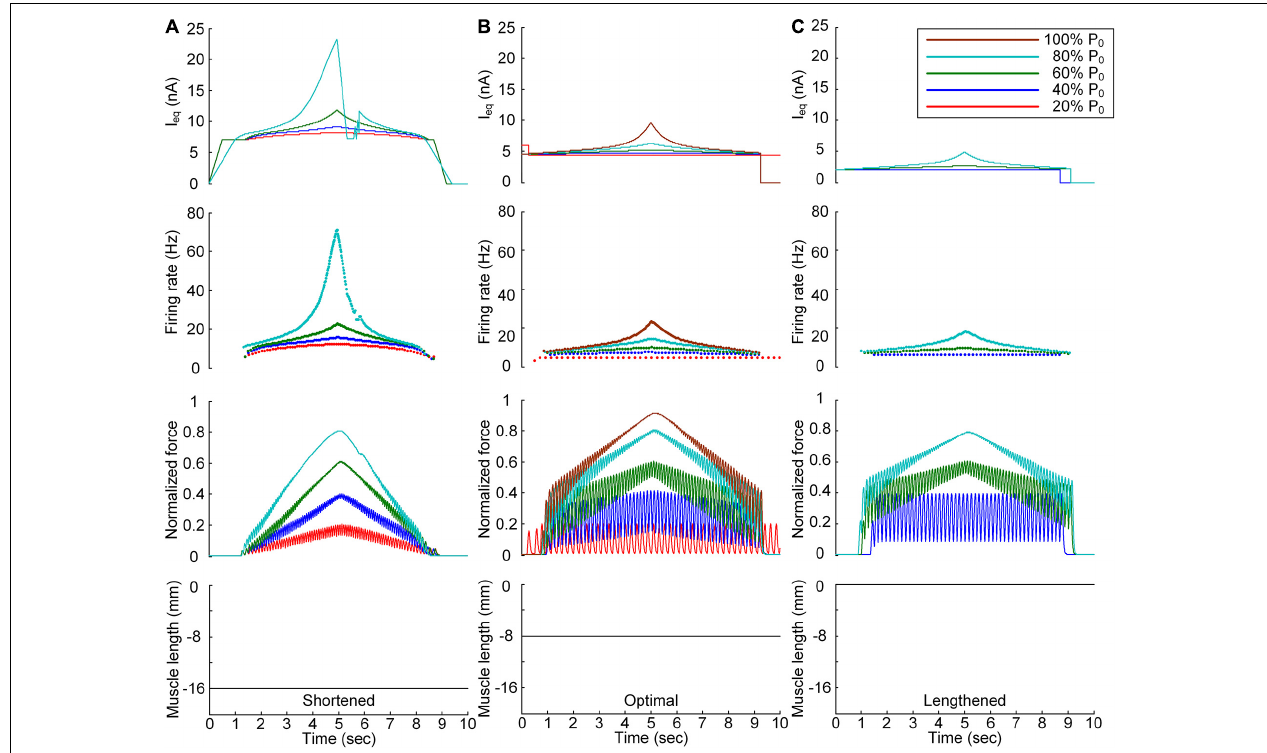
FIGURE 3 | Continuous stimulation waveforms for linear force production. Intensities of continuous current stimulation (I eq ) applied to the somatic compartment ( top ), instantaneous firing rate ( upper middle ) in the motoneuron, and normalized muscle force ( lower middle ) produced by the muscle unit at the three muscle lengths ( bottom ): physiologically minimum (A) , optimal (B) , and maximum muscle lengths (C) . The level of force production produced by the motor unit is denoted as a percentage of the maximal isometric force (P 0 ) at the optimal muscle length and indicated with different